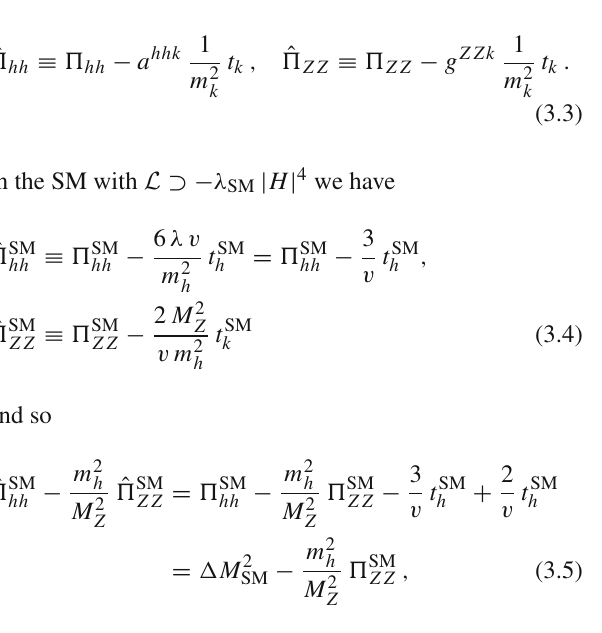
prescription of including tadpole diagrams, this leads